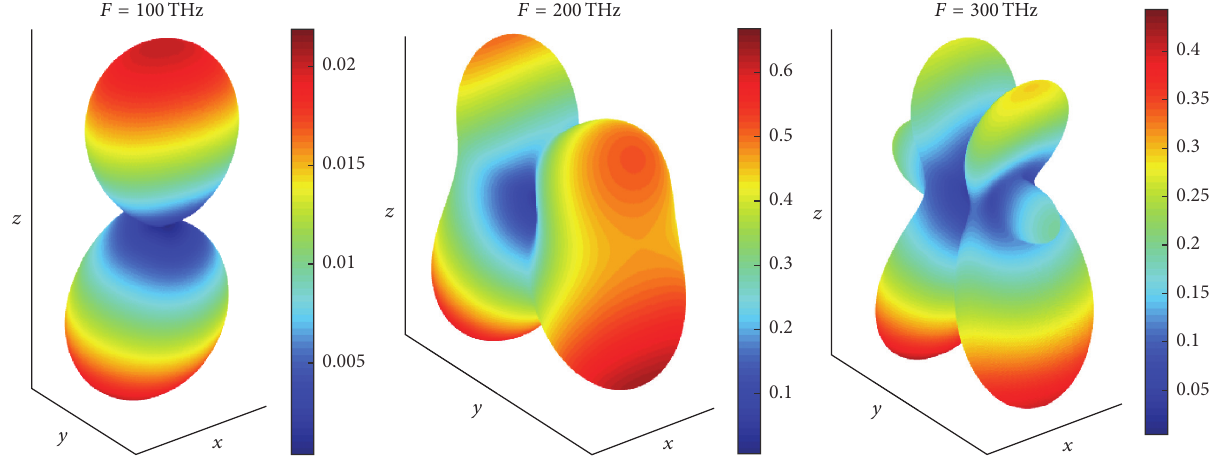
Figure 17: 3D far field gain radiation pattern of the circuit for 𝐹 = 100, 200, and 300